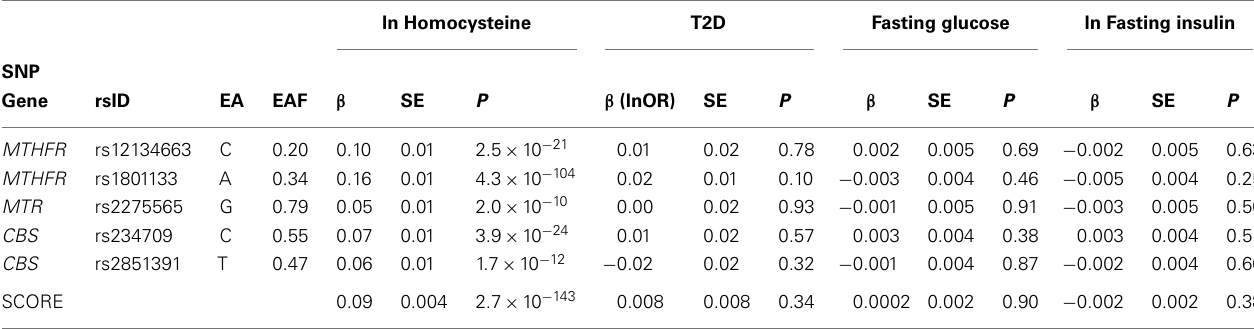
Table 1 |Association of Hcy SNPs with diabetes and related traits, based on large genome-wide association studies . ln